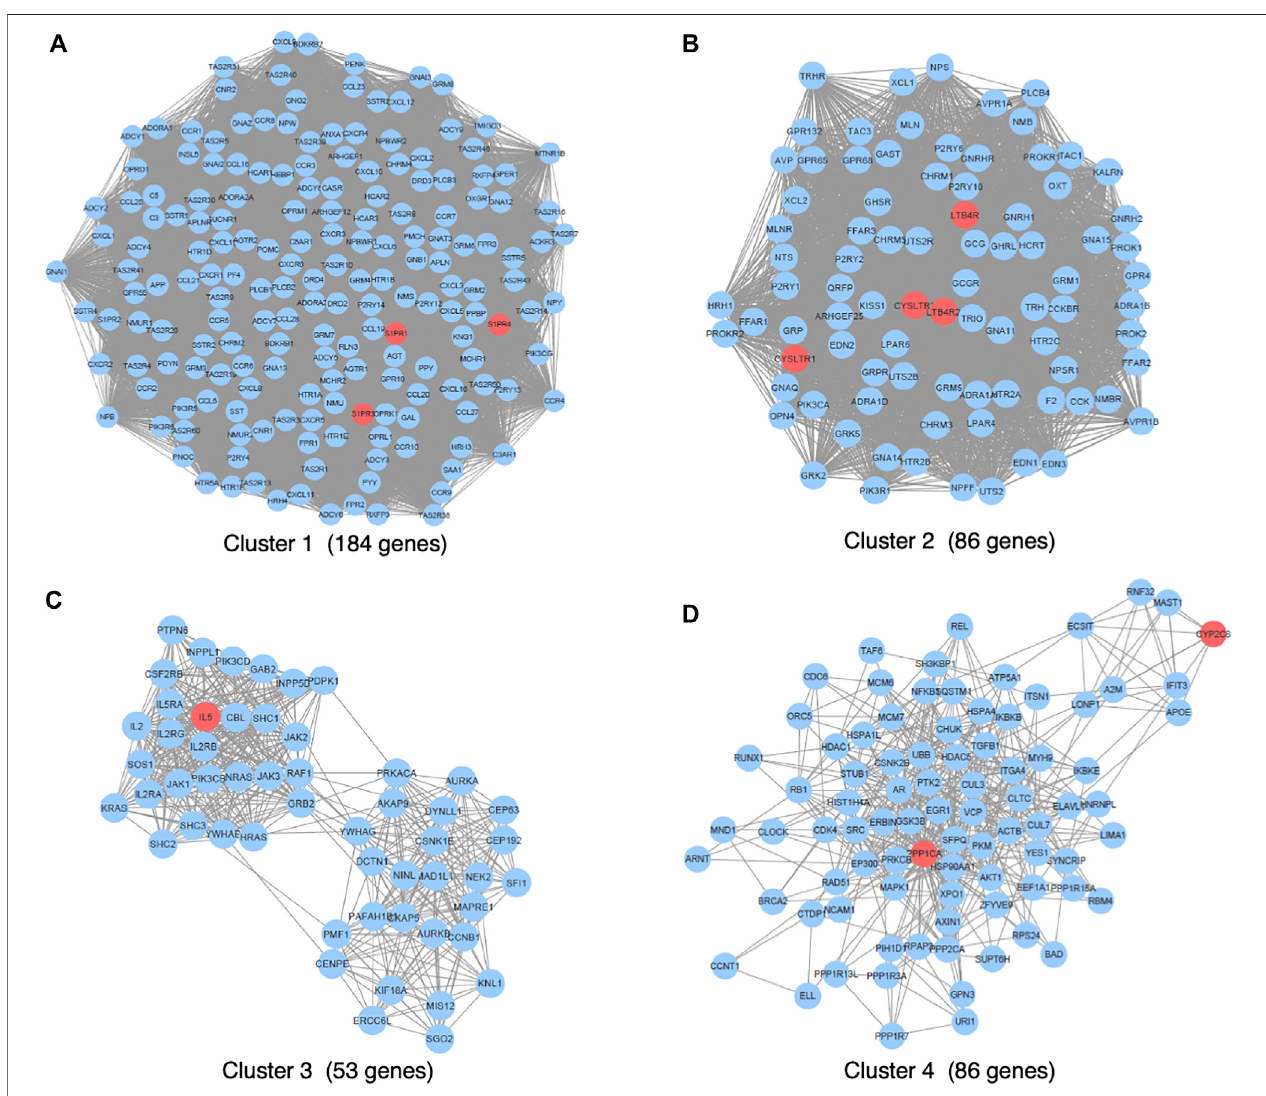
FIGURE 1 | Top four gene interaction networks based on the MCODE plug-in of Cytoscape.